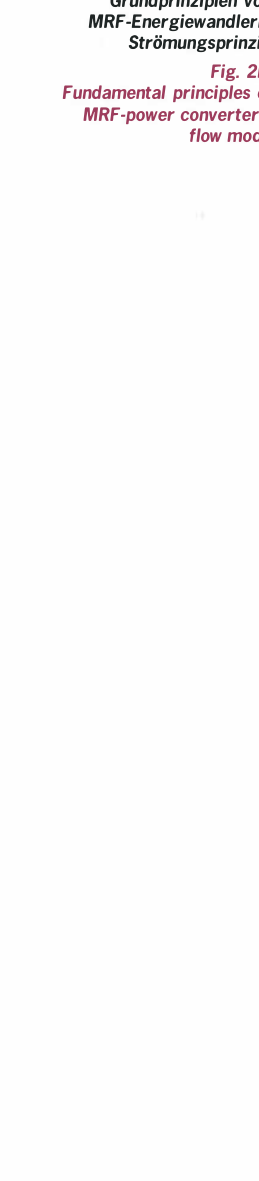
Fig. 2b: Fundamental principles of MRF-power converters: flow mode